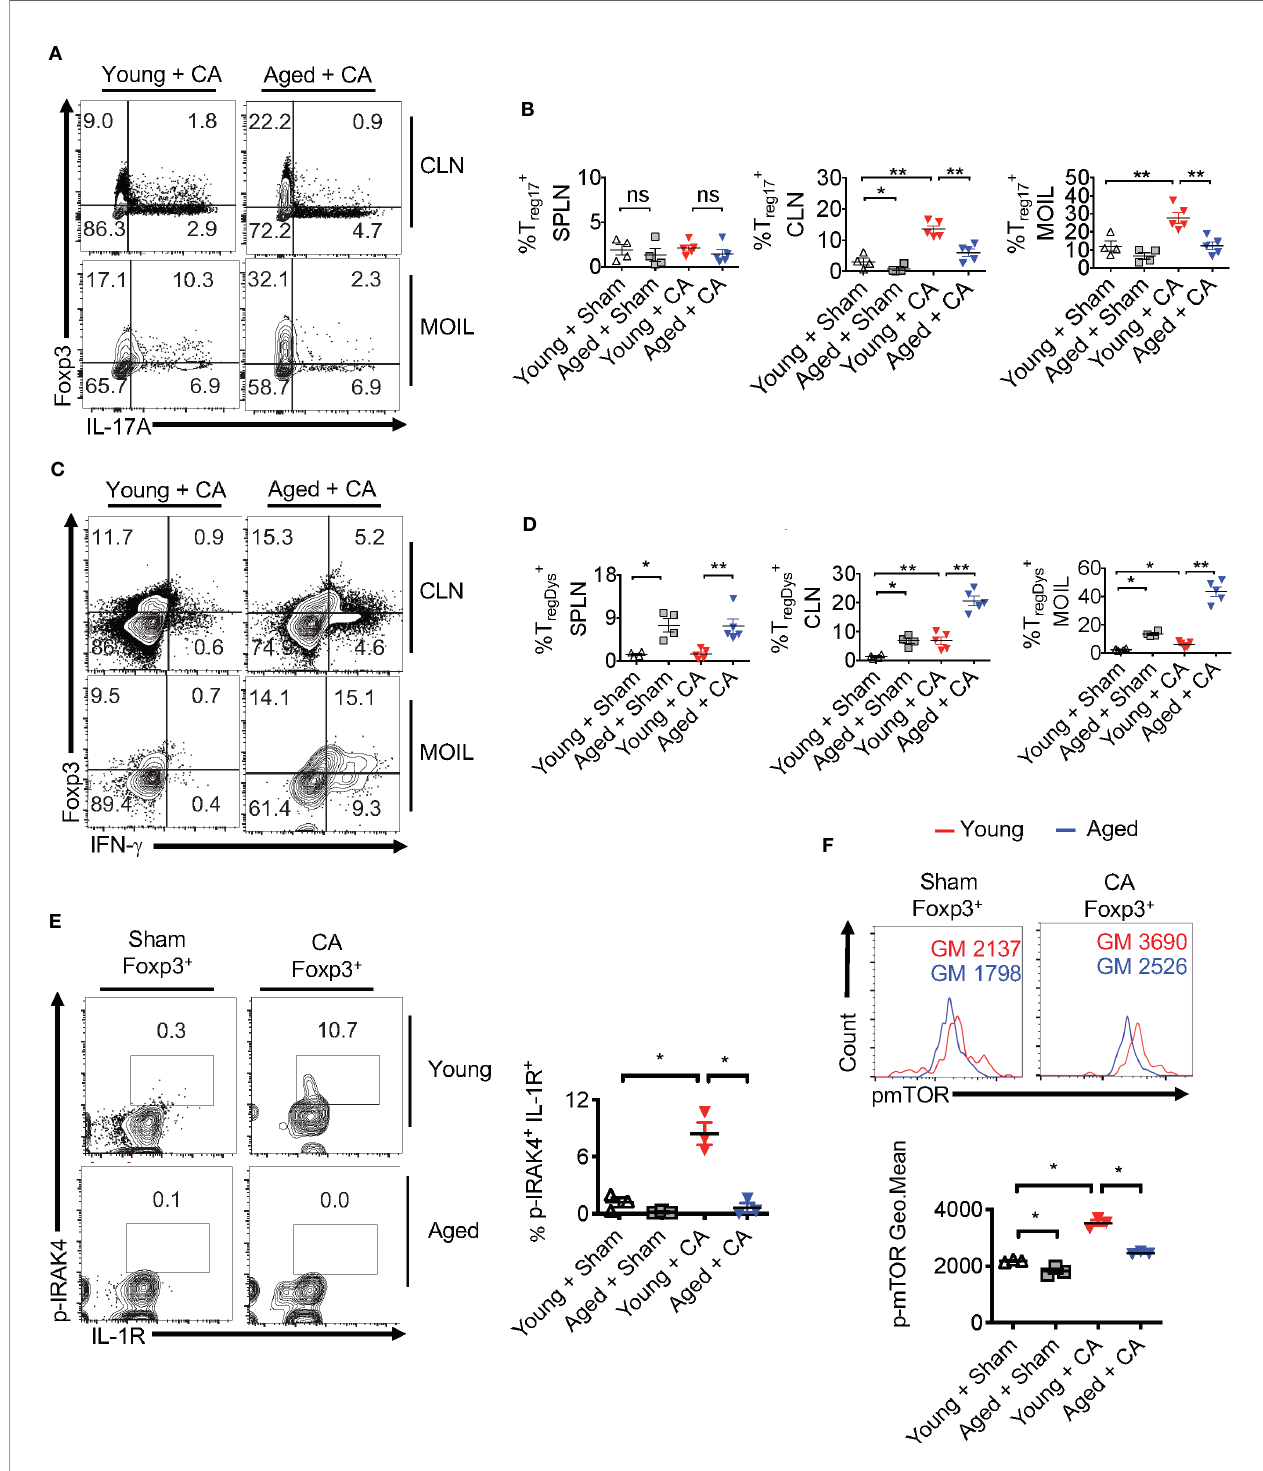
FIGURE 9 | T reg 17 and T regDys alterations are accompanied by loss of IRAK-4 and mTOR activation in T regs in infected aged mice. Young and Aged mice were infected with CA or Sham as in Figure 8 . Flow cytometric analyses of CD3 + CD4 + gated cells for IL-17A and Foxp3 (A, B) , IFN- g and Foxp3 (C, D) , on day 5 after infection. Statistical analyses of Foxp3 + IL-17A + (% T reg 17) (B) , and Foxp3 + IFN- g + (% T regDys ) (D) , using data points from (A, B) , respectively. (E, F) Mice were infected for 2 days. Flow cytometry analyses of CD3 + CD4 + Foxp3 + gated cells for p-IRAK and IL-1R ( E , left and right) and p-mTOR ( F , top and bottom) in Foxp3 + T regs . Geometric mean fl uorescence intensities (GM) are indicated in the histogram plots. Mean values ± SEM are plotted in statistical analyses. These data show one of four independent experiments showing similar results. (*P < 0.05; Mann Whitney test). **P < 0.005. NS, non-signi fi